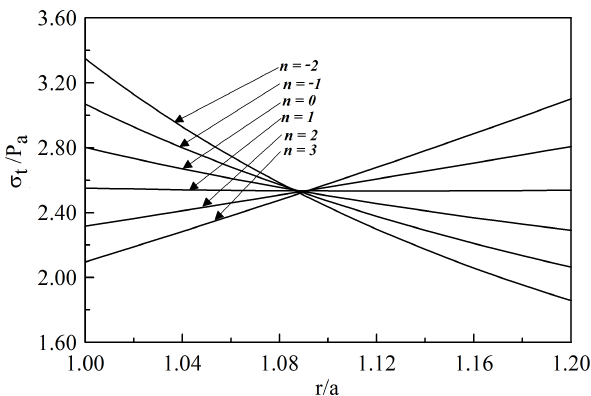
Figure 14: Radially distributed tangential stress